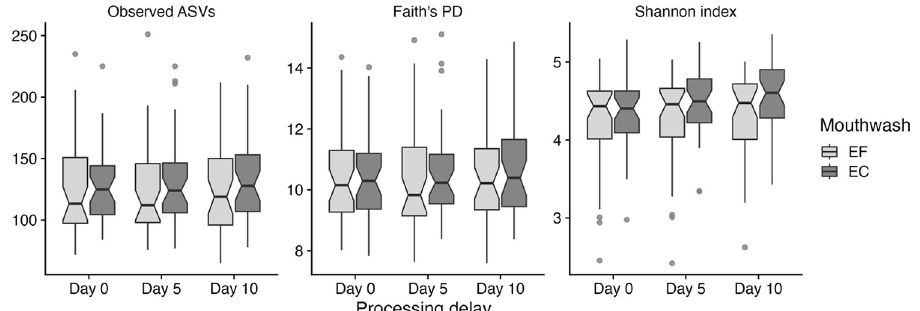
Fig 1. Comparison of alpha diversity metrics between ethanol-free (EF) and ethanol-containing (EC) mouthwashes by processing time. Medians are marked by the horizontal lines in the boxes. Observations outside 1.5 times the interquartile range above the upper quartile and below the lower quartile are shown as outliers. Notches represent 95% confidence intervals for comparing medians. Differences between the two mouthwash types were tested using the Wilcoxon signed-rank test. Significant differences between the two mouthwashes were detected for observed ASVs and the Shannon index for samples processed 5 days (observed ASVs: P = 0.0112; Shannon index: P = 0.000413) and 10 days (observed ASVs: P = 0.00721; Shannon index: P < 0.0001) after collection. No significant differences were observed for all other comparisons.